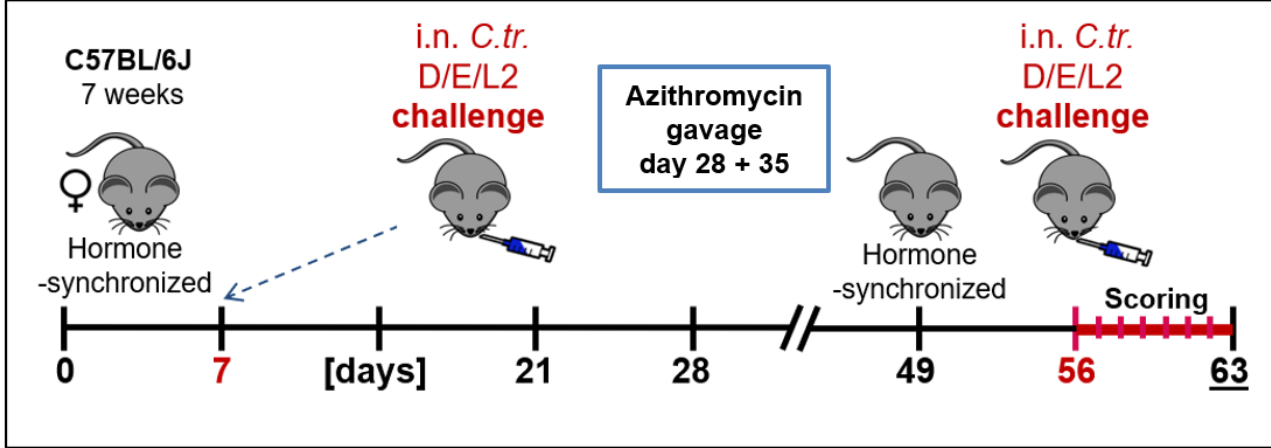
Figure 1. Experimental setup of the C.tr. reinfection model with the primary and secondary i.n. infection.